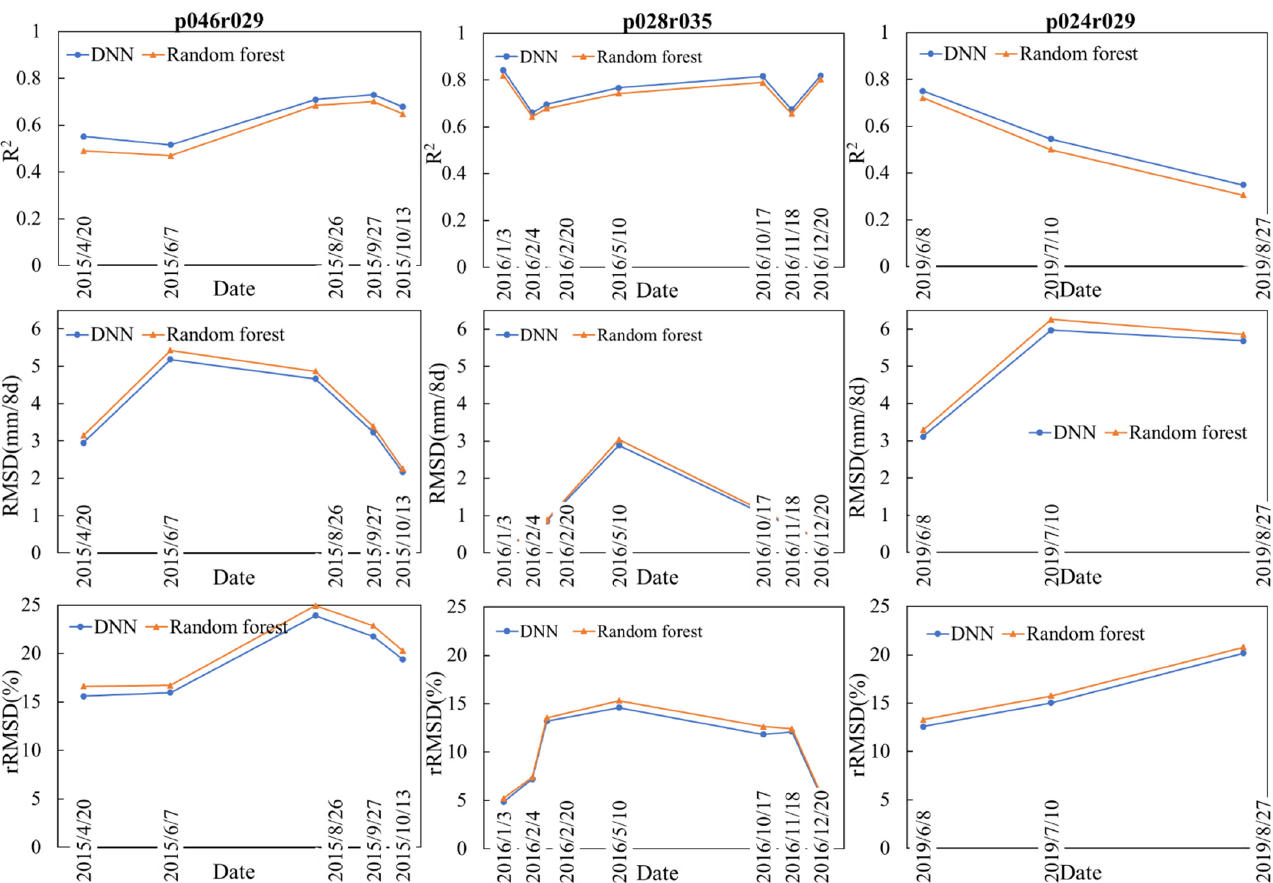
Figure 3. R 2 (top row), RMSD (middle row) and rRMSD (%, bottom row) for the 20% MOD16A2 evaluation samples for the random forest (in yellow) and DNN model (in blue) in three study areas (three different columns).